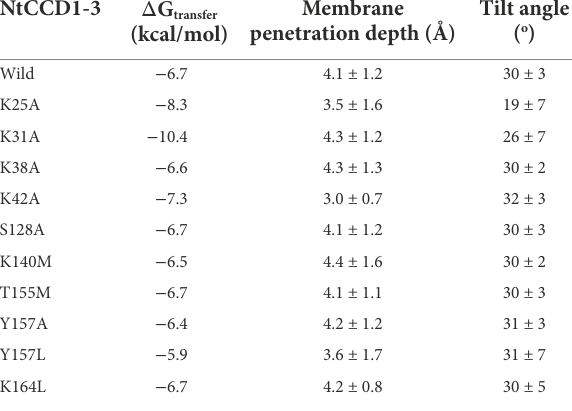
TABLE 2 Silico analysis the membrane interaction parameters of NtCCD1-3 and its mutants.